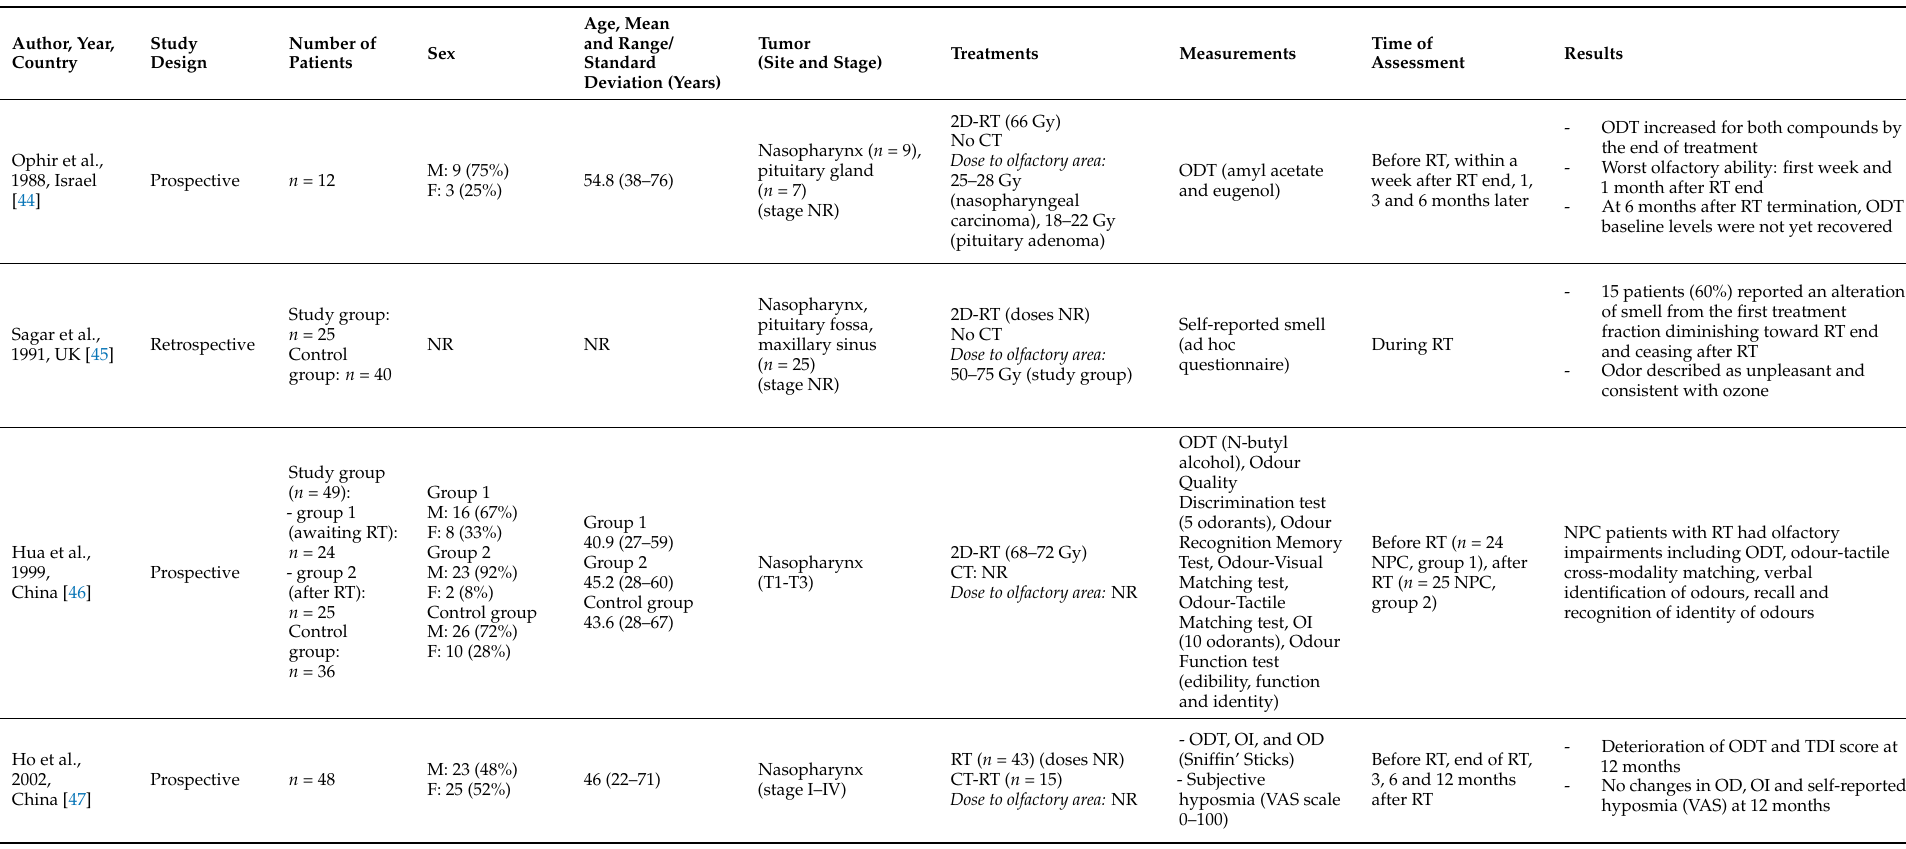
Table 2. Olfactory dysfunction: studies included in the